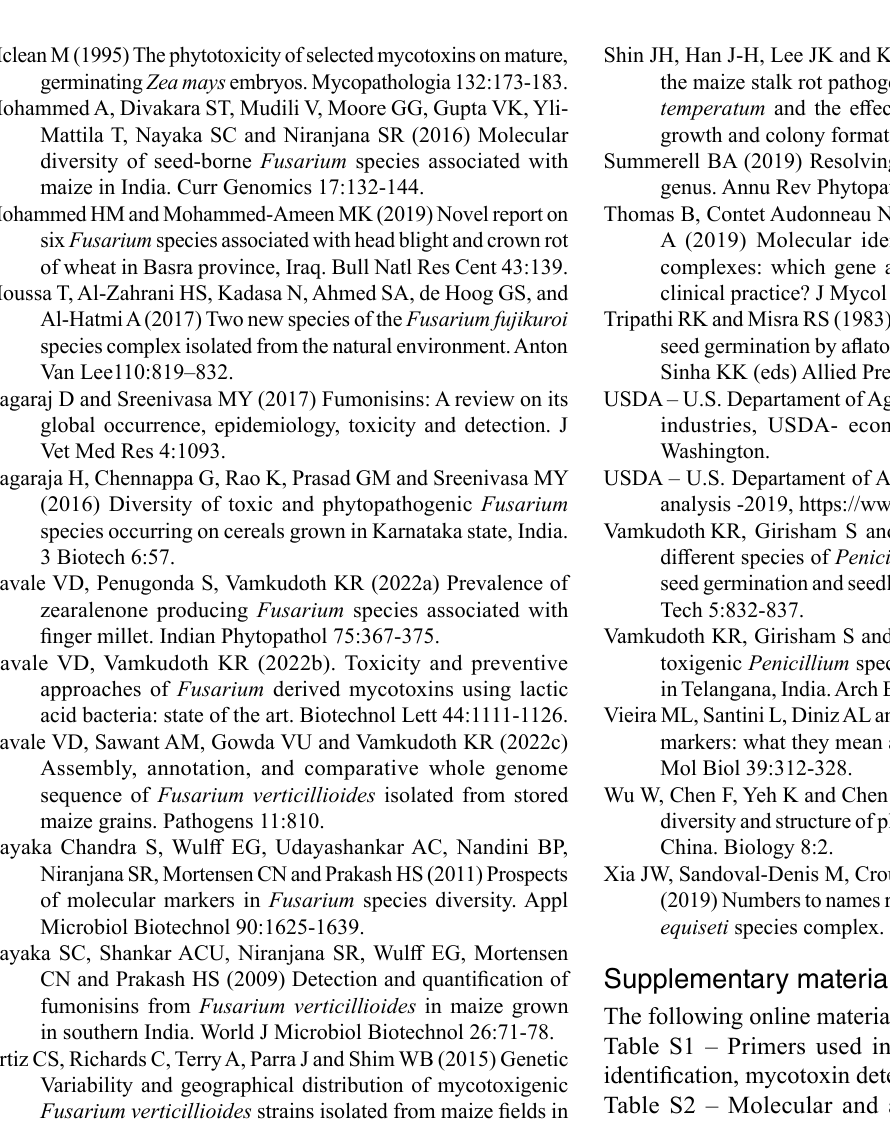
Figure S1 – Molecular identification of Fusarium species by targeting TEF1-α gene. Figure S2 – Molecular detection of Fumonisin by targeting Fum1 gene. Figure S3 – Molecular detection of Fumonisins by FUM13 gene. Figure S4 – LC-MS analysis of fumonisins B1 (FB1). Figure S5 – PCR amplification of Fusarium isolates by (AG)8C ISSR primer. Figure S6 – PCR amplification of Fusarium isolates by (AG)8G ISSR